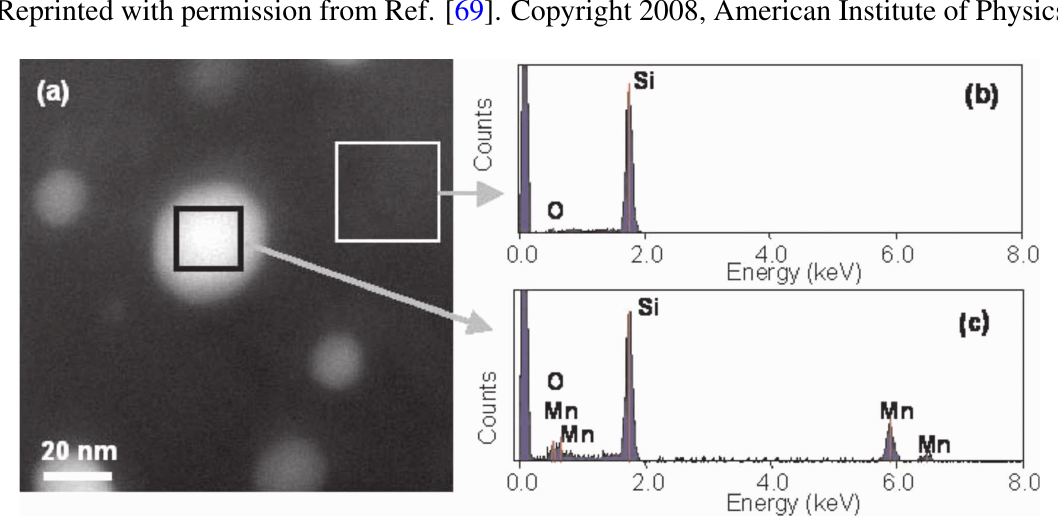
Figure 16 . (a) HAADF STEM image of precipitates in Mn implanted Si. [(b) and (c)] The EDX spectra obtained by scanning the beam in the regions indicated by the boxes on (a). (Reprinted with permission from Ref. [69]. Copyright 2008, American Institute of Physics).